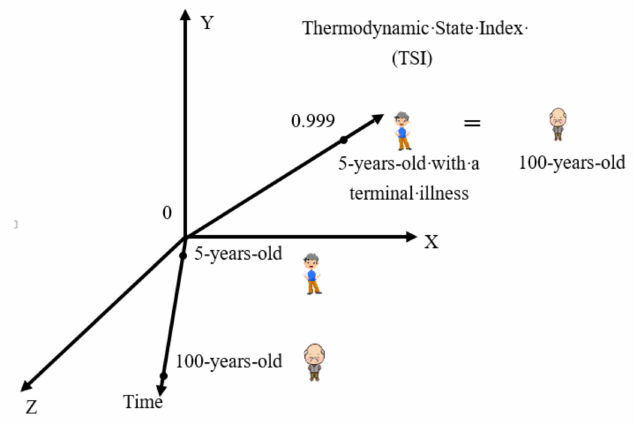
Figure 3. Coordinate system in unified mechanics theory